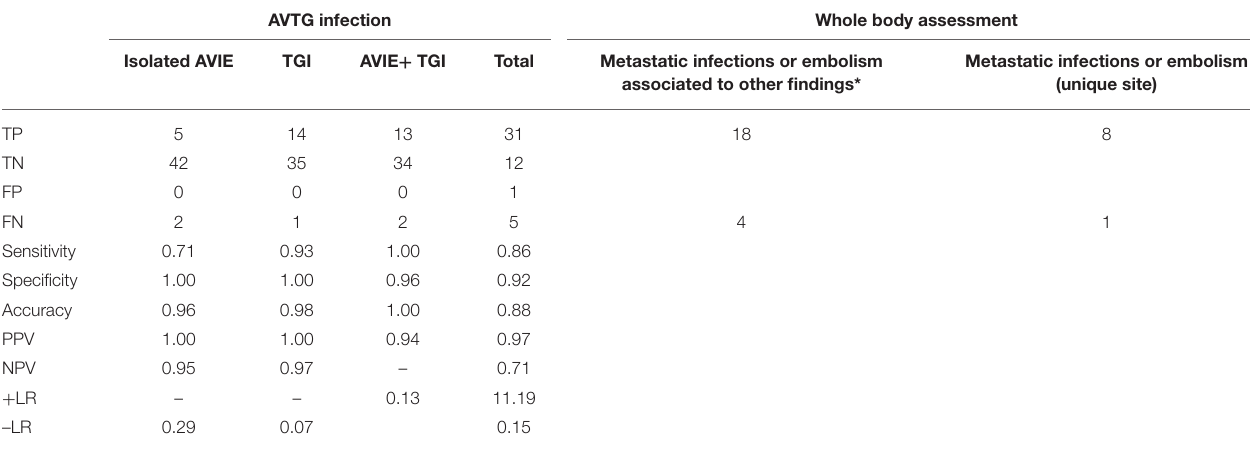
TABLE 2 | Diagnostic performance of 99m Tc-HMPAO-WBC scintigraphy ( n = 49 scans). AVTG